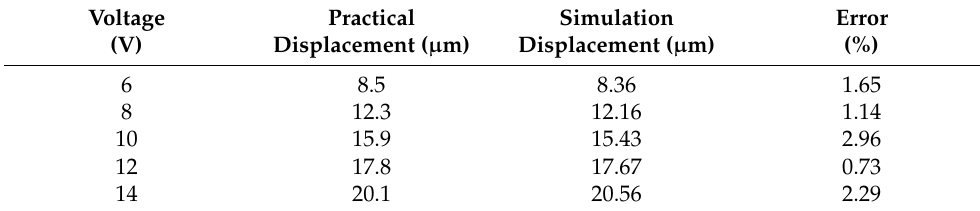
Table 3. Input/output sample of the